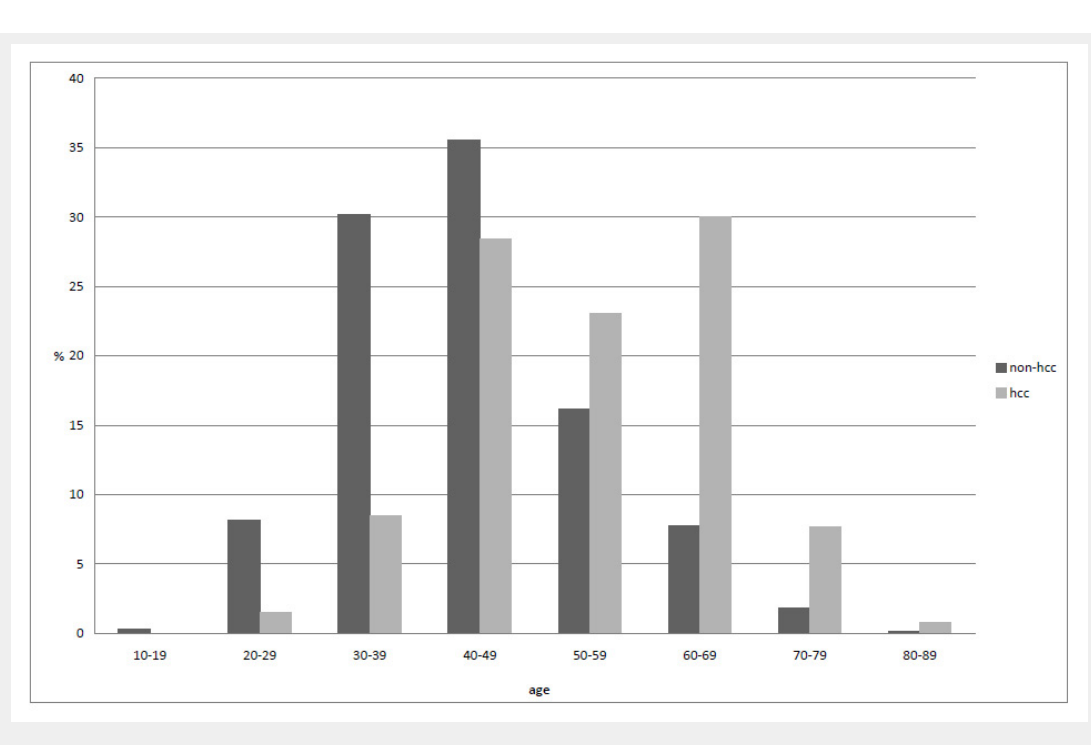
Age distribution in non-HCC and HCC group